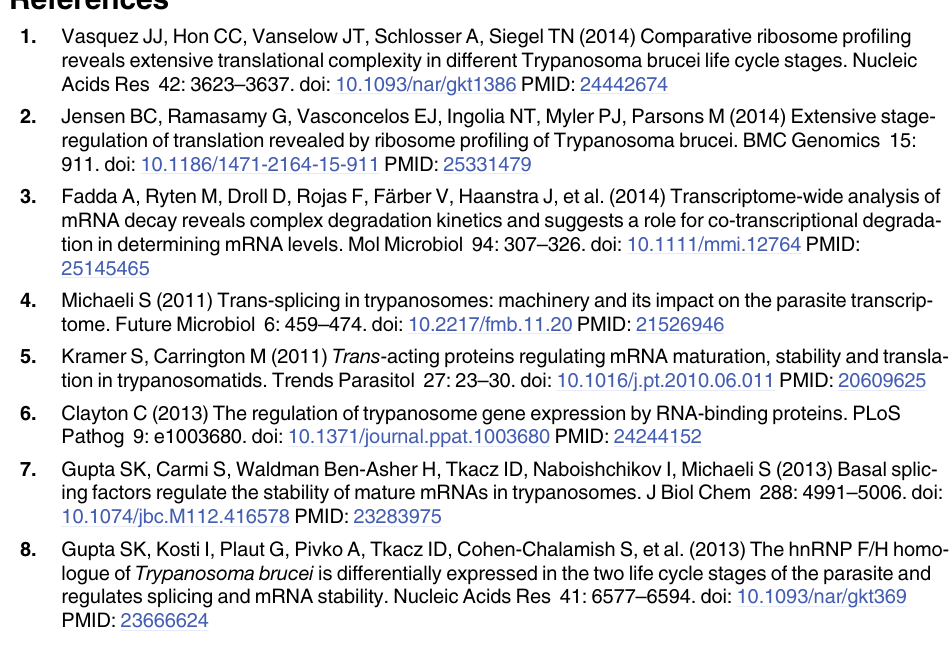
S3 Table. Mass spectrometry results. The numbers of peptides found for each protein (at least 95% confidence) are shown. Proteins are included only if at least two different peptides were found in at least one preparation. Class designations were done manually. BS: bloodstream form; PC: procyclic